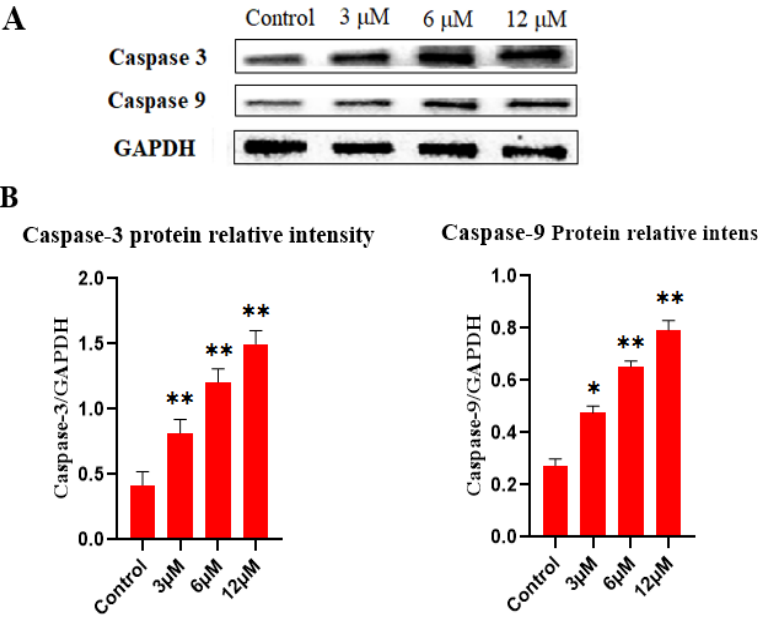
Figure 9. Effects of compound 8f on the expression of caspase-3 and caspase-9 in MCF-7 cells. ( A ) Western blot analysis showing cleaved caspase-3 and cleaved caspase-9 protein expression level. ( B ) Data were revealed as the means ± SD for independent tests in triplicate. * p < 0.05, ** p < 0.01 vs. control ( 8f 0 μ M) group.